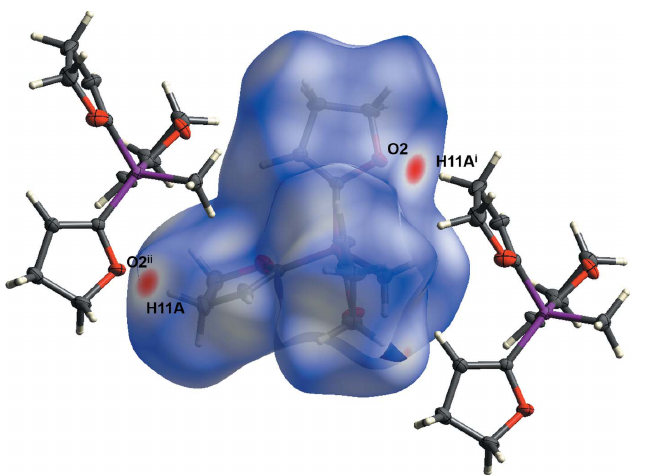
Figure 4 Hirshfeld surface analysis of 1 showing close contacts in the crystal. The weak hydrogen bond between oxygen atom O2 and the H11 A hydrogen atom is labelled. [Symmetry codes: (i) (cid:5) x + 1 (cid:5) z + 1 ]. 2